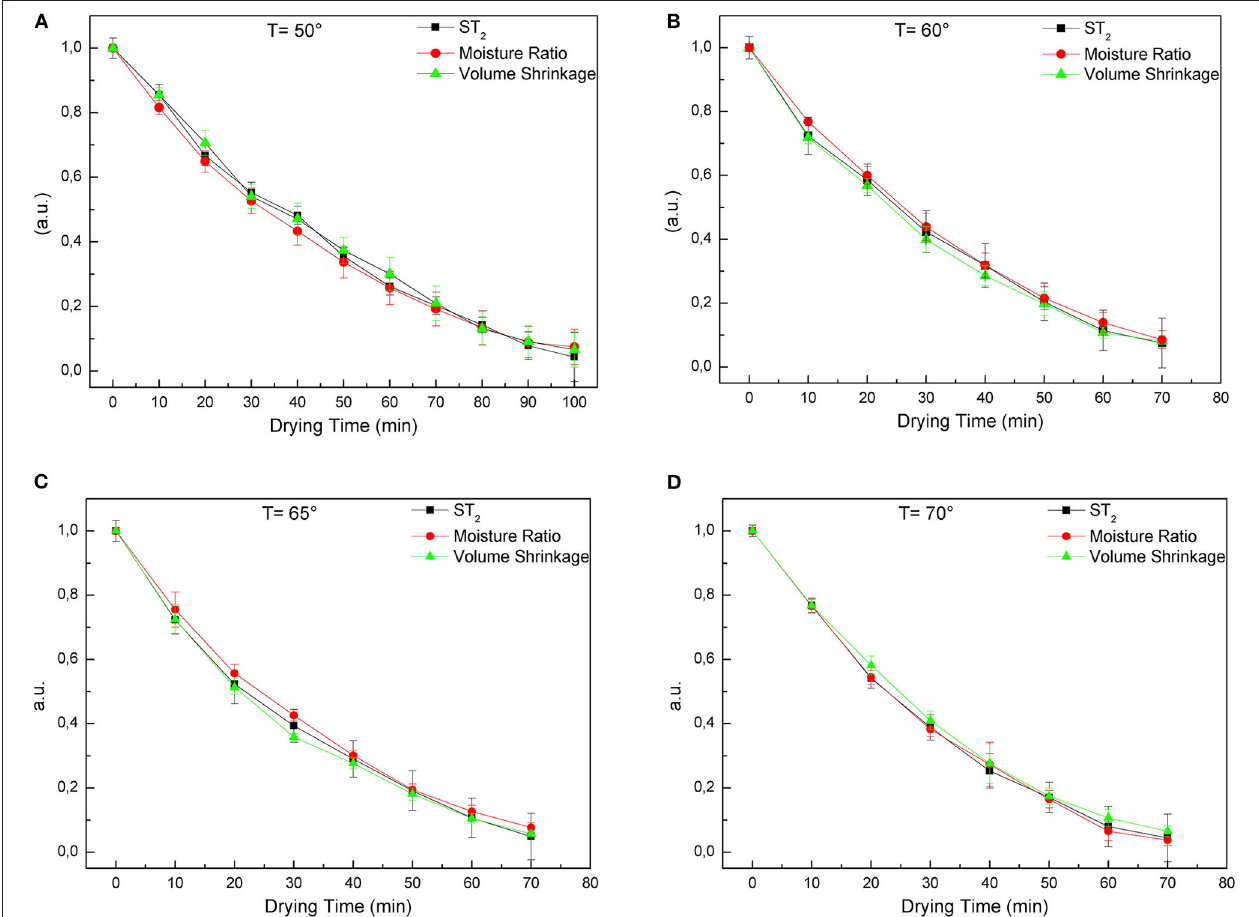
FIGURE 6 | Moisture ratio (a.u.) of samples during drying, obtained by gravimetric method and MRI, and volume shrinkage at (A) 50 ◦ C, (B) 60 ◦ C, (C) 65 ◦ C, and (D) 70 ◦